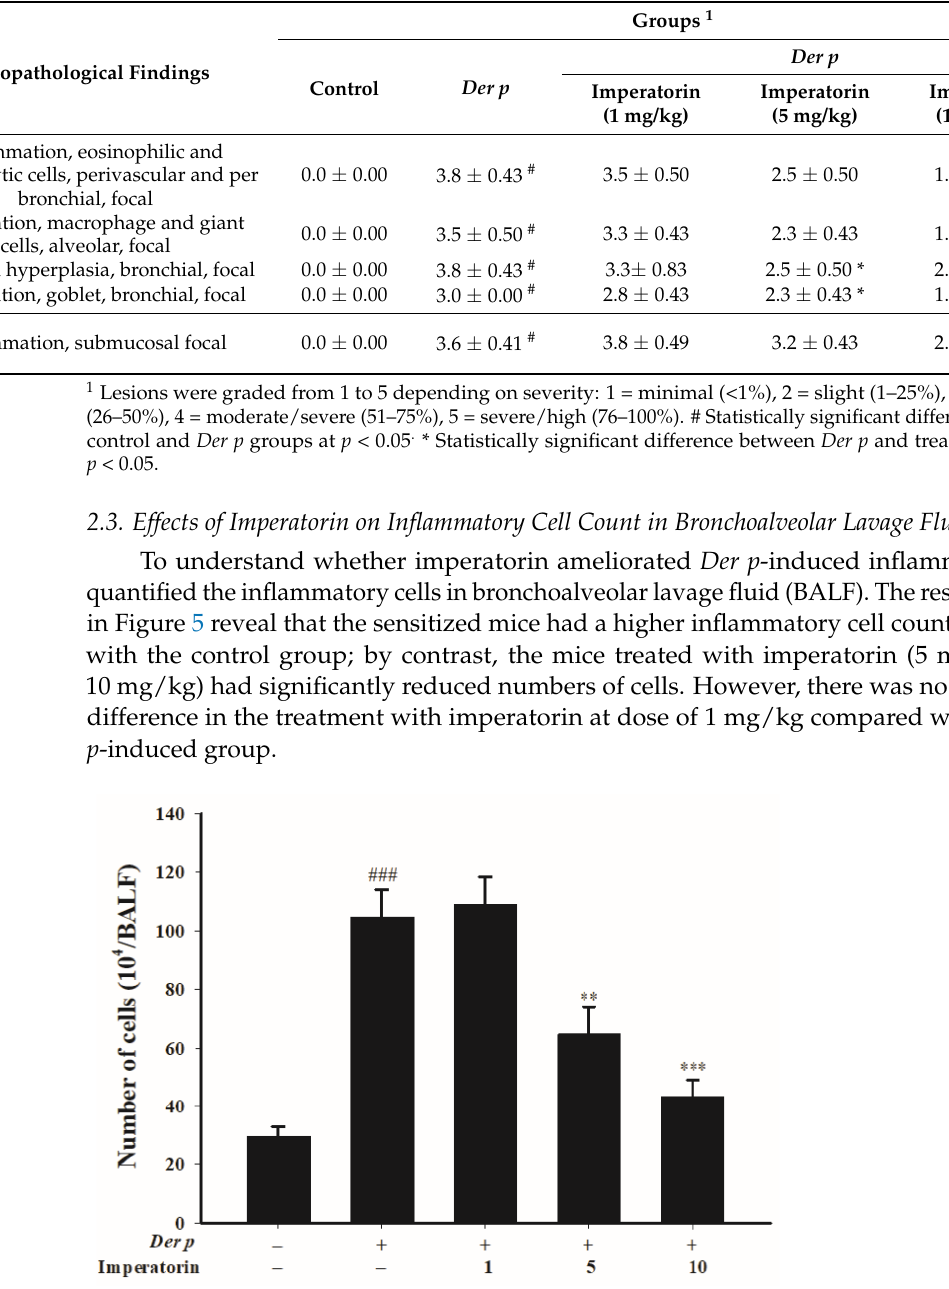
Figure 5. Total counts of inflammatory cells in the BALF of Der p -induced allergic mice treated with imperatorin. ### p < 0.001 compared with the control group, ** p < 0.01 and *** p < 0.001 compared with the Der p -induced group, n = 8 (one-way ANOVA followed by Scheffe’s multiple range test). All data are presented as the mean ± SEM.